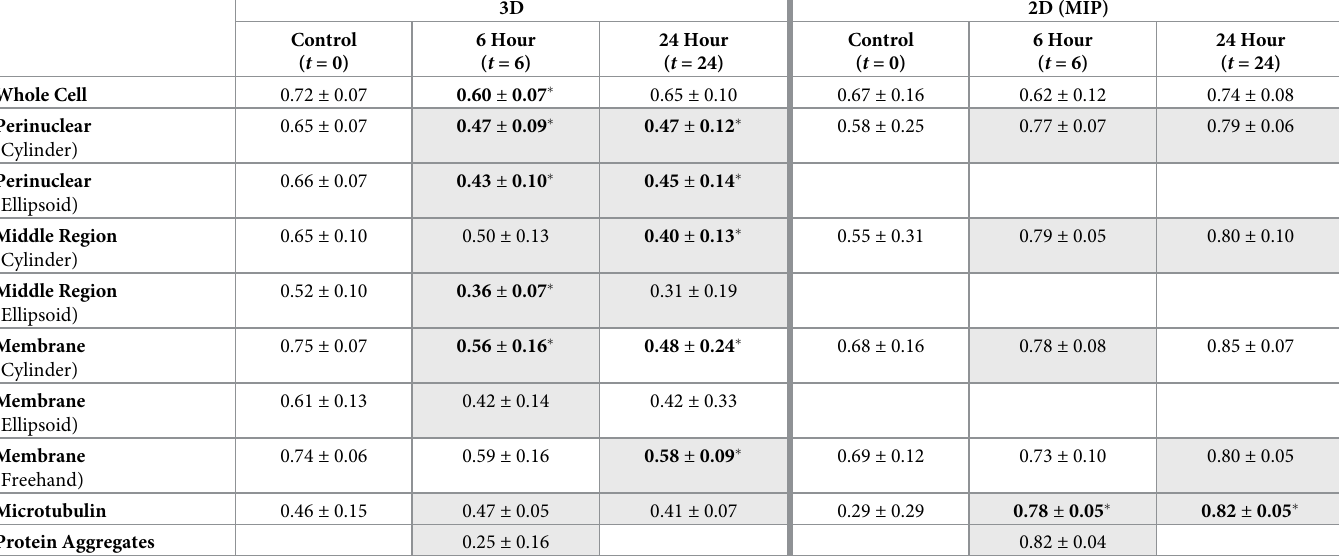
Table 2. Pearson’s correlation coefficients calculated for Tau and acetylated α -tubulin in different areas of GT1-7 cells under control conditions and after exposure to chloroquine for 6 and 24 hours respectively. (Data are presented as mean ± 95% confidence interval). (cid:3) indicates significant differences relative to control ( p < 0.05); A shaded block indicates that the ROI selection methods (i.e. 3D vs 2D) are statistically significantly different. In all cases statistical significance was determined using the two-sample, two-tailed t-test. Protein aggregates were only analyzed at the 6 hour time